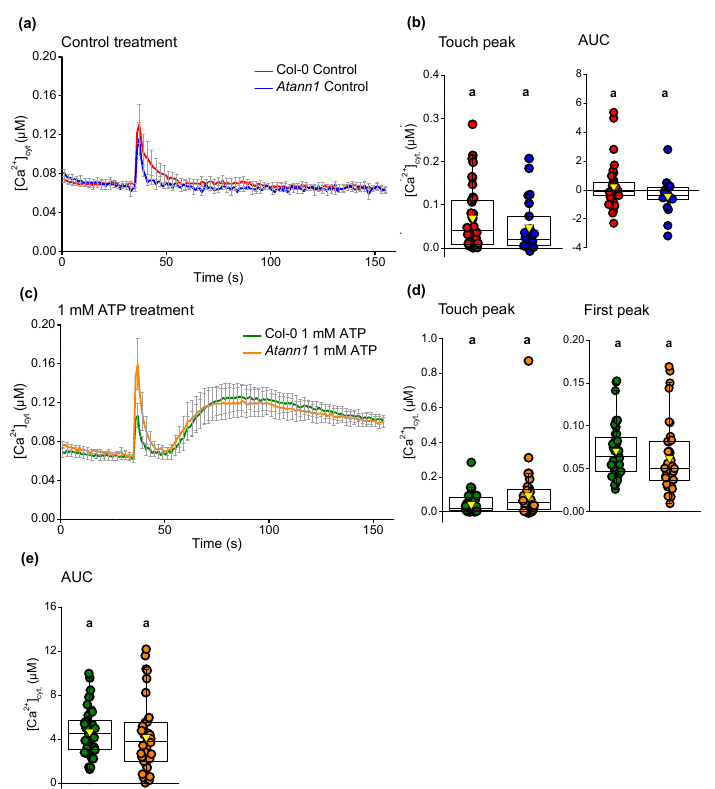
Figure 8. AtANN1 is not needed for eATP-induced [Ca 2+ ] cyt increase in cotyledons. ( a ) Mean (± SEM) time course of [Ca 2+ ] cyt increase due to control treatment of seven-day-old individual cotyledons. ( b ) The [Ca 2+ ] cyt touch peak (± SEM) and the total [Ca 2+ ] cyt accumulation by the AUC (± SEM). Middle line of the boxplot represents the median whereas the inverted triangle represents the mean. ( c ) Mean (± SEM) time course of [Ca 2+ ] cyt increase due to 1 mM eATP treatment. ( d ) The [Ca 2+ ] cyt touch peak values (± SEM) and the first peak values (± SEM). ( e ) Total [Ca 2+ ] cyt accumulated values (± SEM) from the AUC. Data were obtained from four experiments with n = 21–39 cotyledons per genotype and treatment. p -values obtained from ANOVA with Tukey’s post-hoc test. Identical lower-case letters indicate an insignificant difference between means ( p > 0.05).